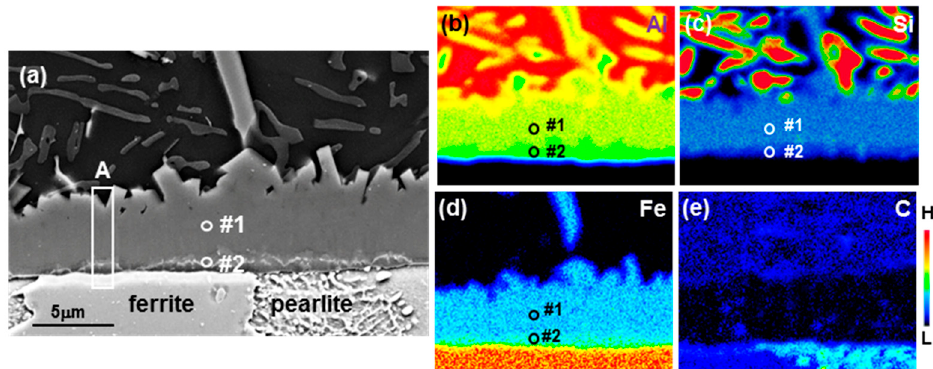
Figure 4. ( a ) Secondary electron microscopy (SEM) images for the Area C in Figure 1a along with field-emission electron probe micro-analyzer (EPMA) elemental mapping analysis for ( b ) Al, ( c ) Si, ( d ) Fe, and ( e ) C.